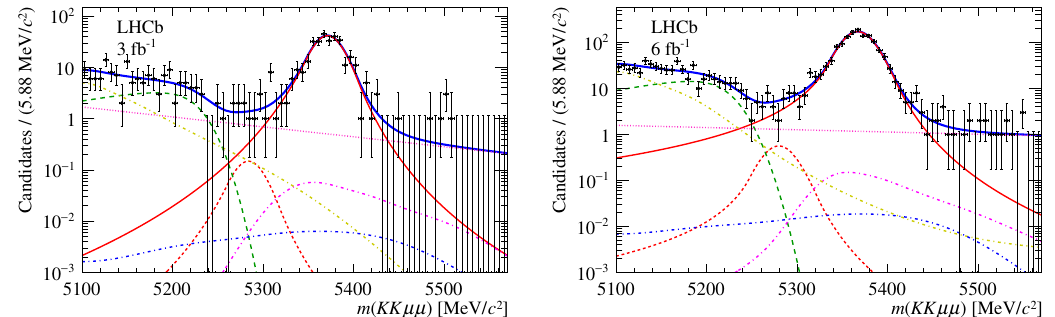
Figure 3. The K + K − µ + µ − mass distributions of selected nonresonant B 0 in (left) Run 1 and (right) Run 2 data. The red solid line is B 0 is B 0 → φµ + µ − signal, the green dashed line is the partially reconstructed background component, the violet dotted line is the combinatorial background component, the blue dash-dot line is the Λ 0 → pK − µ + µ − background component, the violet dash-dot line is the B 0 → K ∗ 0 ( → K + π − ) µ + µ − b background component, and the orange dash-dot line is the B 0